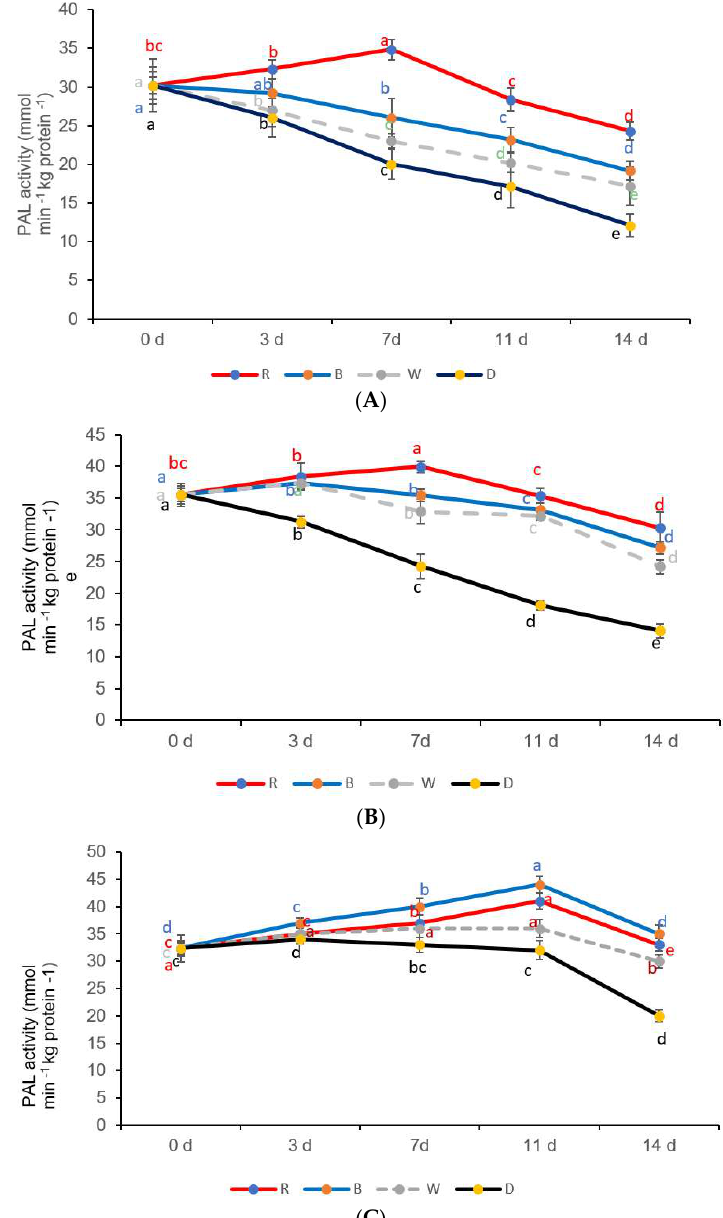
Figure 5. Phenylalanine ammonia lyase (PAL) activity in ( A ) yellow sweet pepper, (B) green sweet pepper, and ( C ) red sweet pepper fresh-cuts exposed to di ff erent LED light treatments and storage times from 0 to 14 days for 8 h at 7 ◦ C. R —Red, B—Blue, W—White light; D—Darkness (control). Data include 0, 3, 7, 11, and 14 days storage time. Di ff erent letters above each bar indicate significant di ff erences ( p < 0.05) using Fisher’s LSD